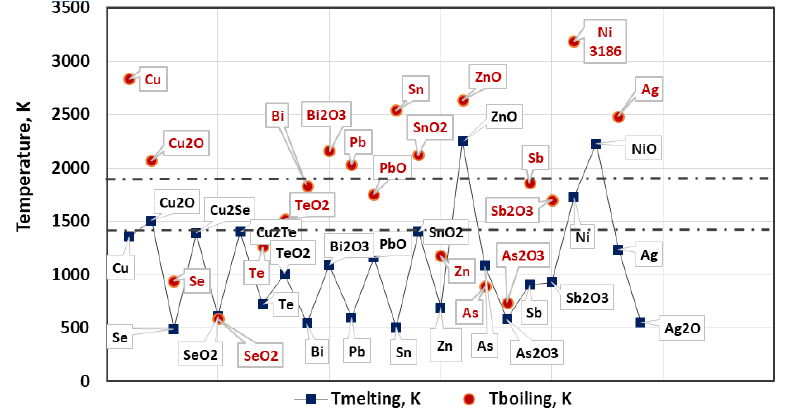
Figure 2. Melting and boiling temperatures of studied metals and compounds.